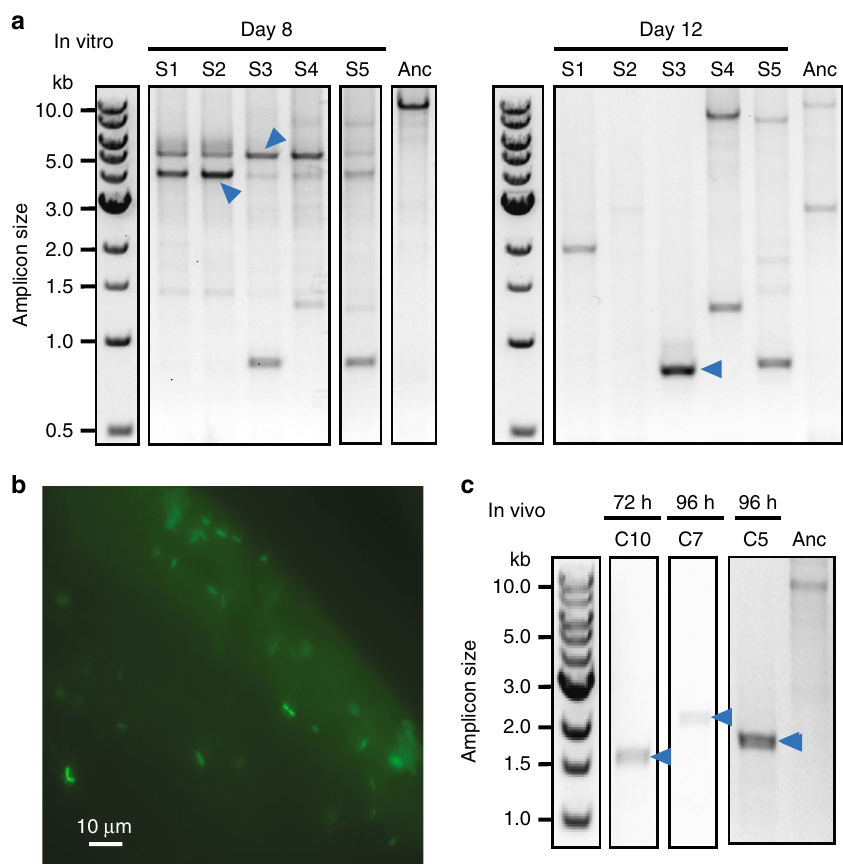
Fig. 3 Satellite plasmids evolve in S. alvi in the honey bee gut. a SPs detected as linearized PCR amplicons during the in vitro propagation of S. alvi at days 8 and 12 in fi ve experimental populations S1 – S5. b Fluorescence micrograph showing colonization of the bee gut ileum 24 h after inoculation with S. alvi carrying plasmid pQGS. c Satellite plasmids detected as linearized PCR amplicons from DNA extracts of the guts of individual bees reared in different enclosures (C1 – C10) at 72 or 96 h after inoculation. Full results for all populations evolved in vivo are shown in Supplementary Fig. 4. Blue arrows in all panels are bands that were Sanger sequenced to validate that they represent SPs (Supplementary Fig. 3 and Supplementary Table 1). Source data are provided as a Source Data fi le.